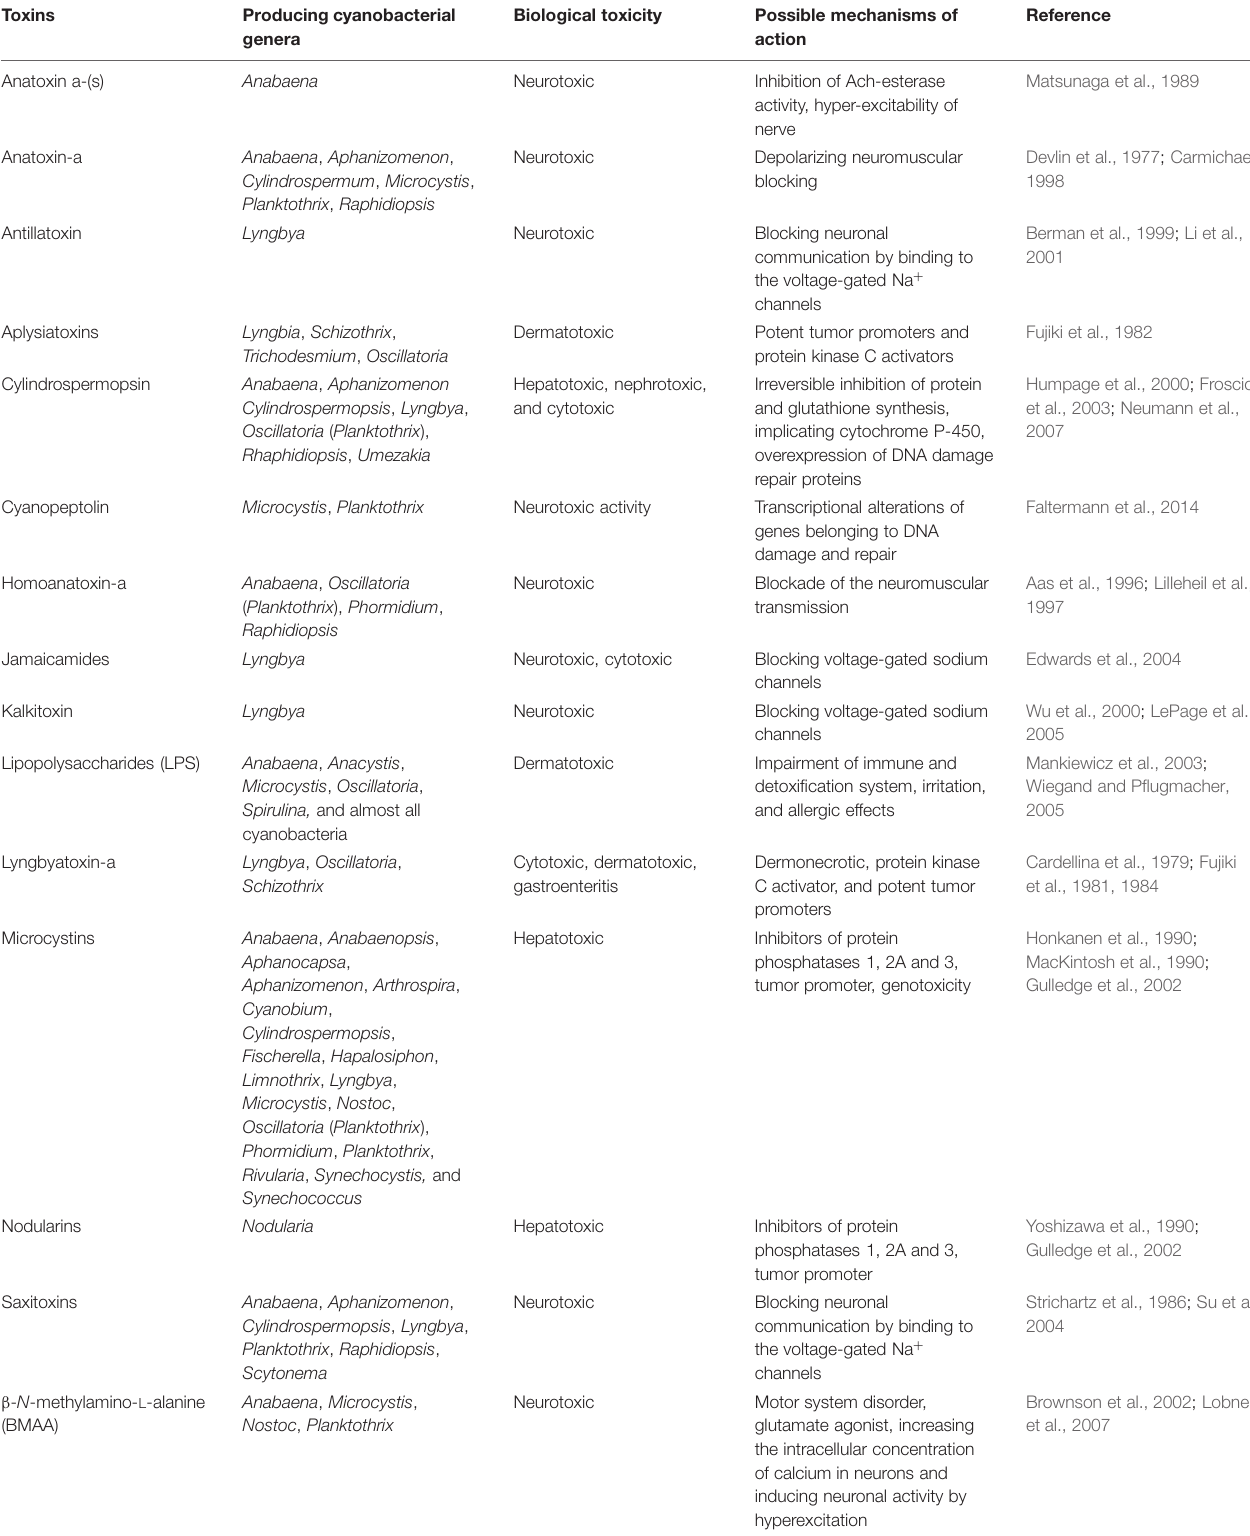
TABLE 1 | Some common cyanotoxins found in different cyanobacteria and their possible toxicity and mode of